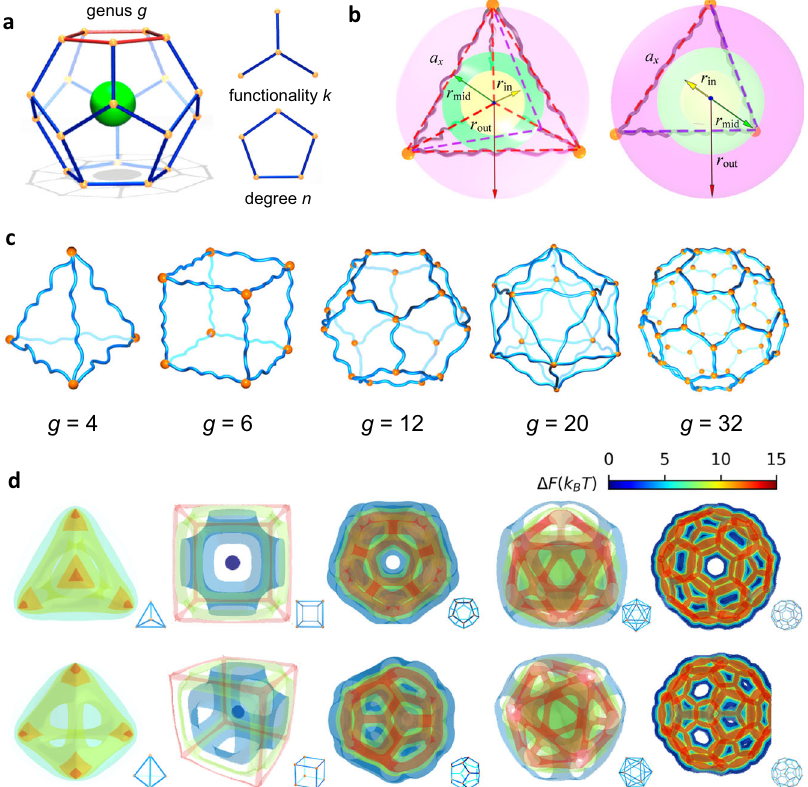
Fig. 1 Detailed overview of network topology and the free energy landscape. a Schematic representation of a particle in a macromolecular network with topological parameters: genus g , degree n , and functionality k . b Schematic diagram of the scaling parameters of a network cell at g = 4, where arrows shown in yellow, green and red denote respectively inradius r in , midradius r mid , and circumradius r out of the cell from different views. c Schematic representation of macromolecular network cells with different topologies. d Isosurfaces of the free energy change Δ F of a particle in networks with different topologies marked at the right bottom, where the scaled diameter d/a x = 1.4. The color bar on the top right corner encode s the value of Δ F